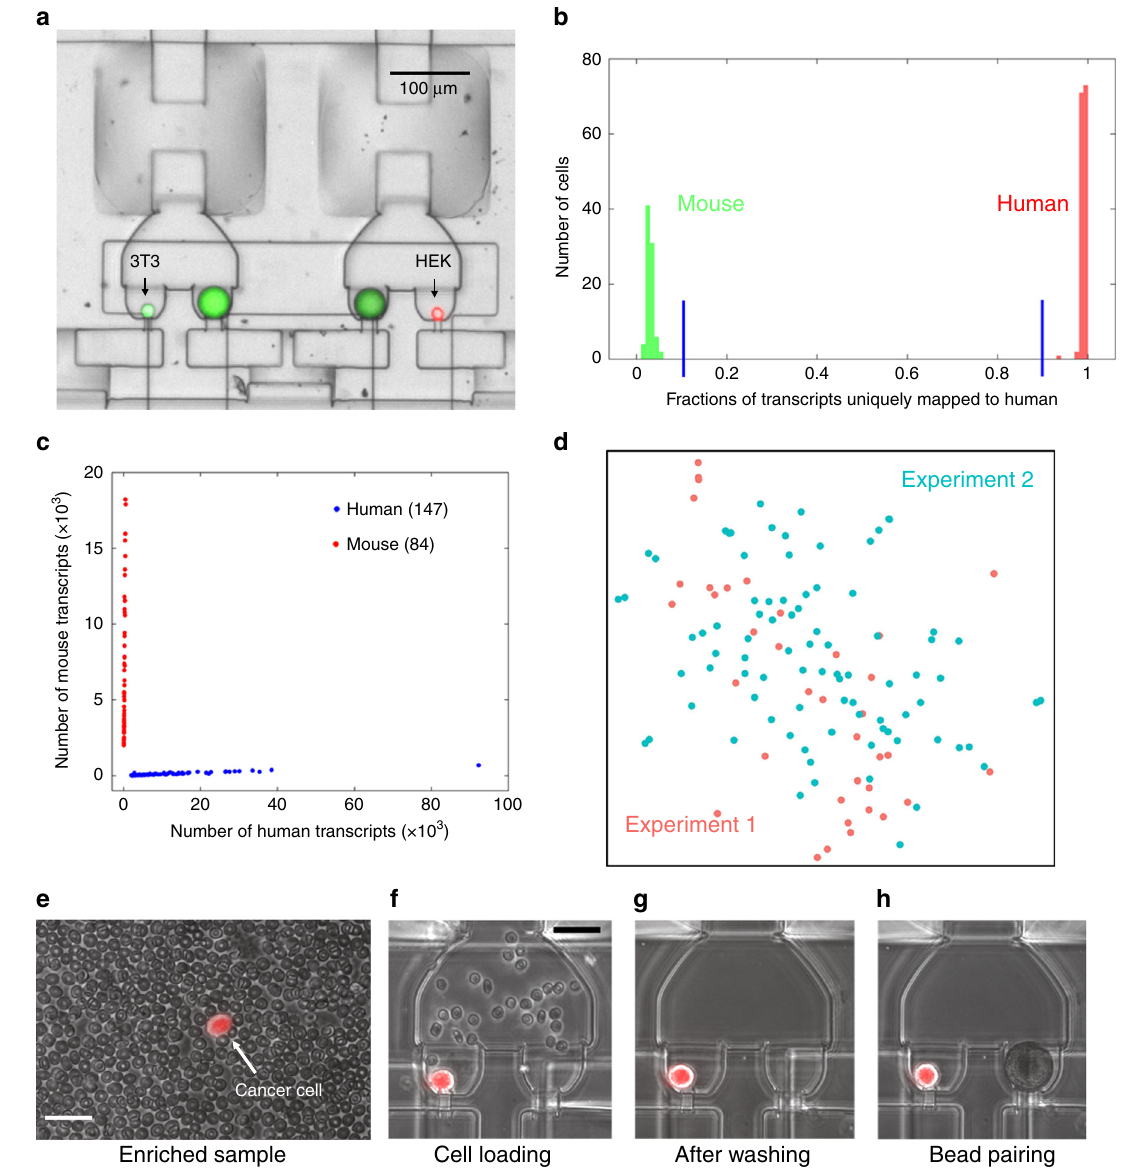
Fig. 2 Species-mixing experiment and CTC loading in Hydro-Seq. a – d Species-mixing experiment. a Chambers with beads paired to a mouse cell (3T3 with green fl uorescence) and a human cell (HEK with red fl uorescence). Fluorescent imaging was applied to examine the pairing condition and verify the capture. b Histograms of the percent cross-species contamination of mixed mouse and human cells. Cells with over 90% transcripts mapped to human were labelled red and cells with over 90% transcripts mapped to mouse were labeled green. c Species-mixing analysis highlights the single-cell resolution RNA-sequencing with zero cellular cross contamination. Each red dot represents a mouse cell and each blue dot represents a human cell. d tSNE plot of single-cell expression analysis for HEK cells from two independent Hydro-Seq experiments. (Experiment 1 labeled with red color and experiment 2 labeled with cyan color) Each dot represents a cell. Cells from two experiments are evenly dispersed and do not show any clustering, indicating good reproducibility of Hydro-Seq. e – h CTC loading in Hydro-Seq. e After CTC enrichment, single-cell RNA-sequencing (scRNA-seq) of the CTCs is still challenged by the presence of many background blood cells. (Scale bar: 25 µ m) f Erythrocytes fl owing through the chamber during sample loading. (Scale bar: 25 µ m) g During the washing cycle, the bead valve is opened to remove other blood cells through the bead capture fl ow channel, achieving contamination-free single CTC isolation for bead pairing. h Pairing a bead to a single CTC for scRNA-seq. Source data are provided as a Source Data fi